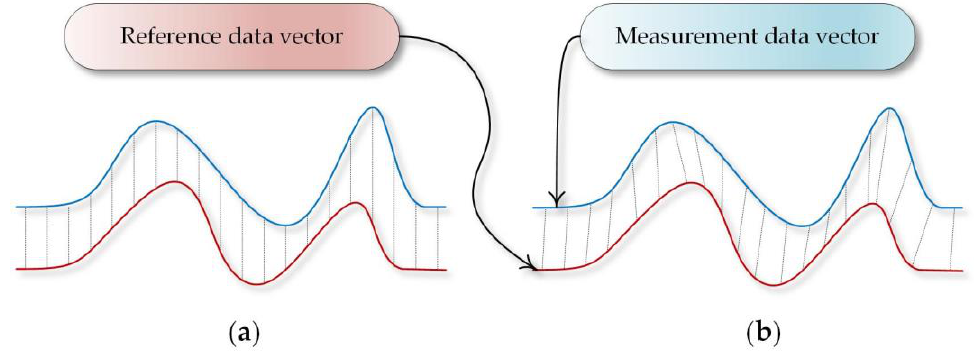
Figure 3. Visualization of shape matching with the use of element-wise Euclidean vector distance ( a ) and Dynamic Time Waring mapping ( b ).